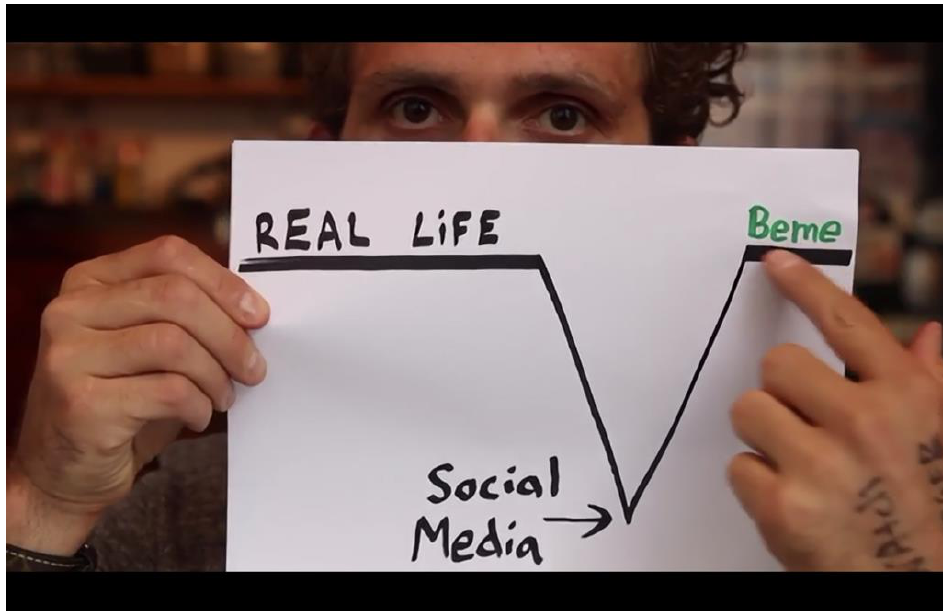
Figure 6. A screenshot from the Beme video, “Meet Beme,” 17 July 2015 [103].